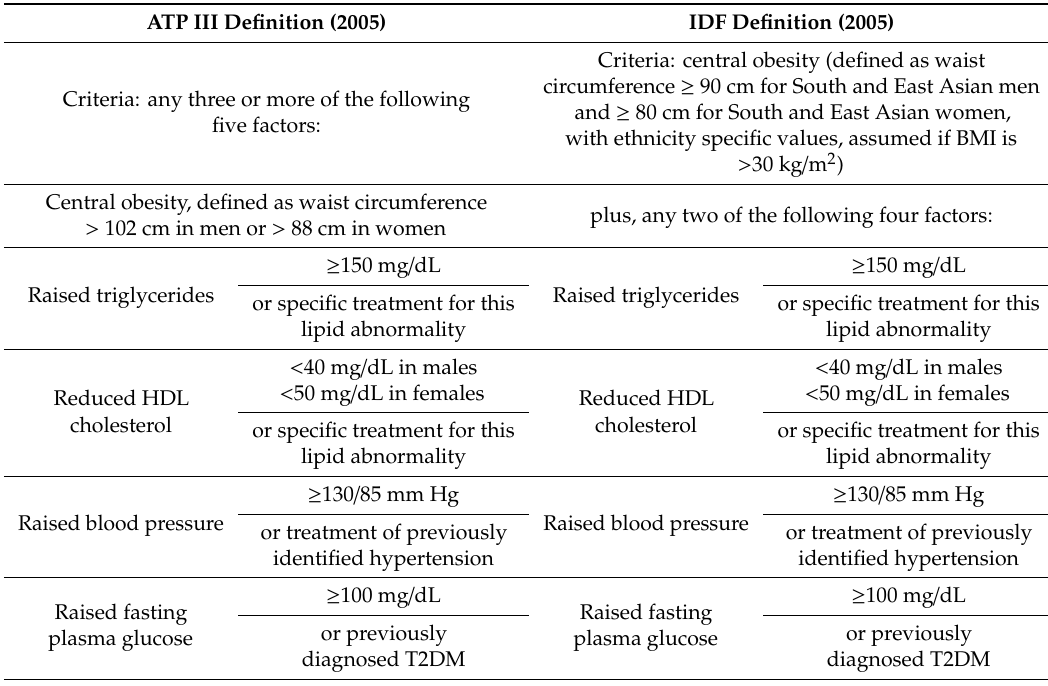
Table 1. MetS as defined by ATP III and IDF